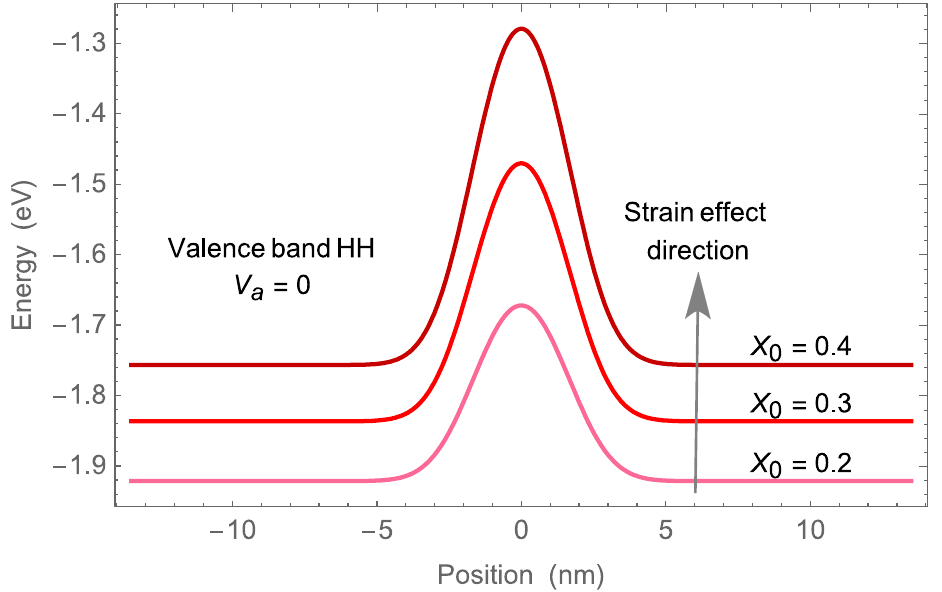
Figure 4. Strain effect direction for valence band (HH) of the In x Ga 1-x N/GaN parabolic LED struc- tures with various mole fractions (𝑥 (cid:2868) ) at an applied bias of 0 V.